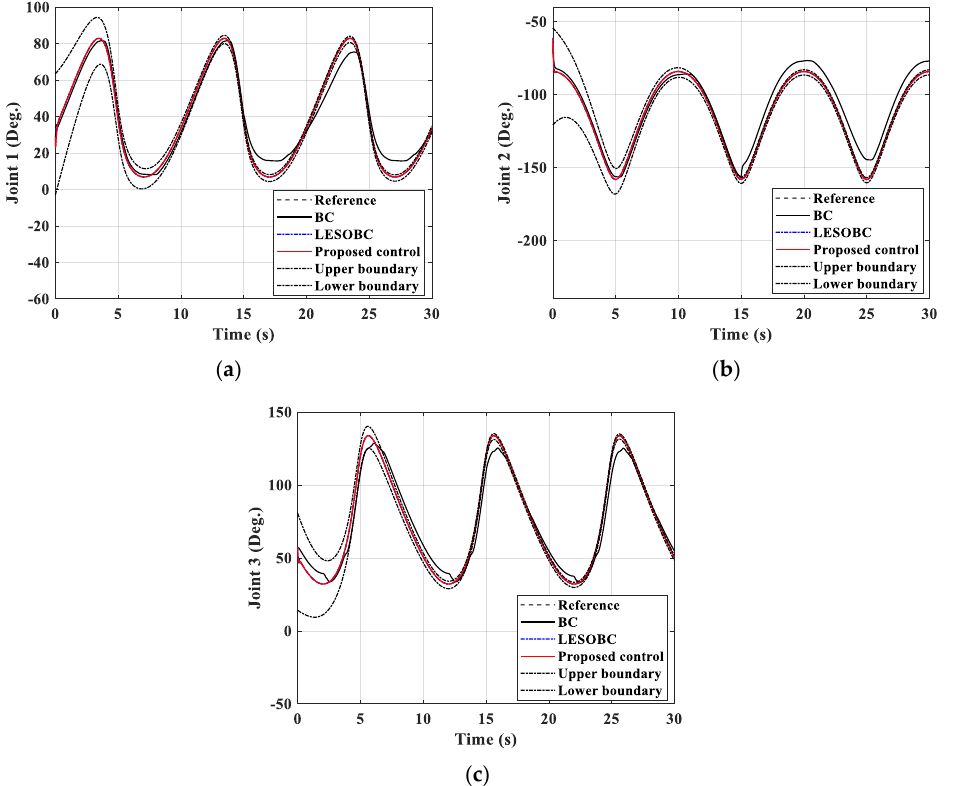
Figure 4. References of the 3-DOF planar manipulator in joint space at 0.1 Hz.